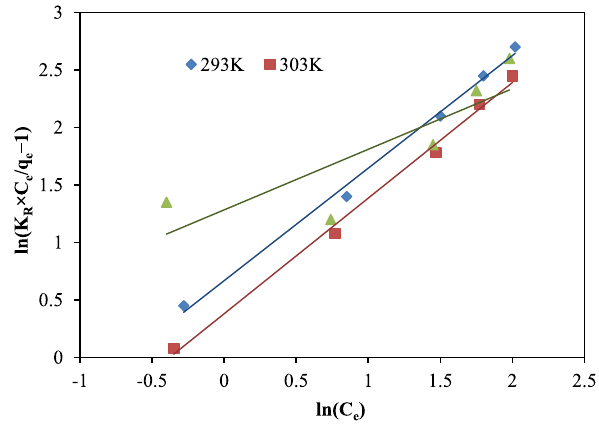
Fig. 12 Redlich–Peterson plot for the removal of fluoride by using